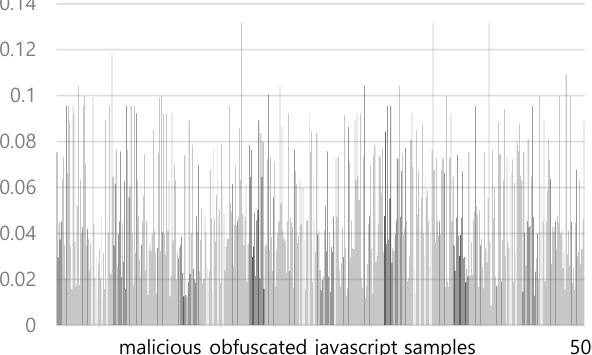
Figure 10. TF-IDF average values over redirection tokens in 500 obfuscated malicious JavaScripts using the revised TF-IDF.